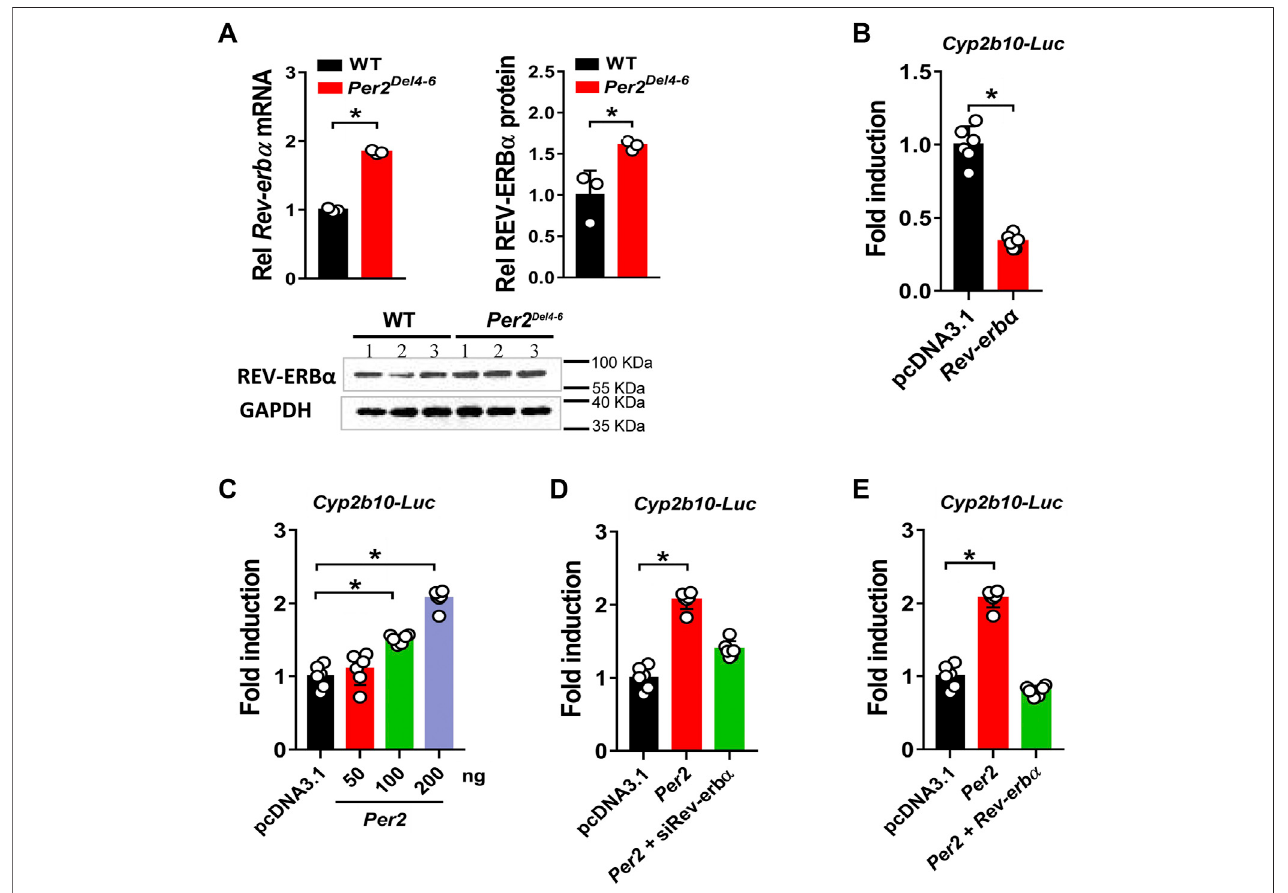
FIGURE 8 | Per2 regulates Cyp2b10 transcription through down-regulating REV-ERB α . (A) Increased expression of REV-ERB α in Per2 Del4-6 mice. Western blot strips (a target protein and a loading control) were cut from one gel. (B) Effects of Rev-erb α overexpression Cyp2b10 - Luc reporter activity in HEK293T cells. (C) Per2 dose-dependently induces Cyp2b10-Luc reporter activity in HEK293T cells. (D) Regulatory effects of Per2 overexpression on Cyp2b10 are attenuated in Rev-erb α - de fi cient HEK293T cells. (E) Rev-erb α reverses the effects of Per2 on Cyp2b10 transcription inHEK293T cells. Dataaremean ± SD ( n (cid:1) 3or 6). Inpanels A/B, *p < 0.05 (t test). In panels (C – E) , *p < 0.05 (one-way ANOVA followed by Bonferroni post hoc test). Rel, Relative.